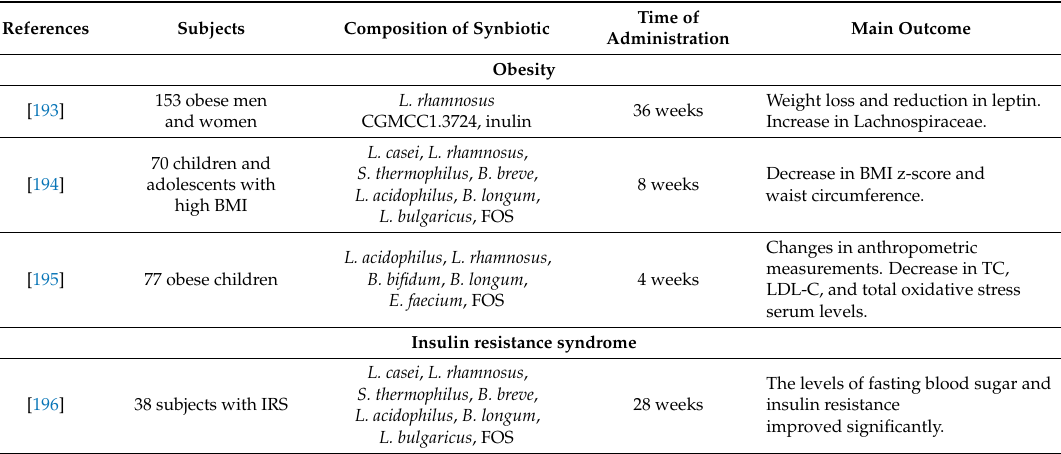
Table 6. Examples of clinical trials regarding the effect of synbiotics on human